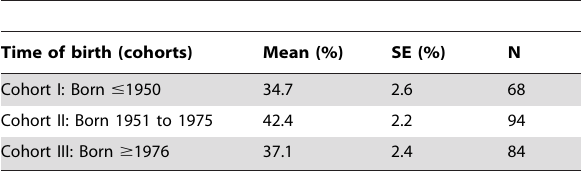
Table 4. Participants’minimal accepted offer (in % of 100 yuan) by